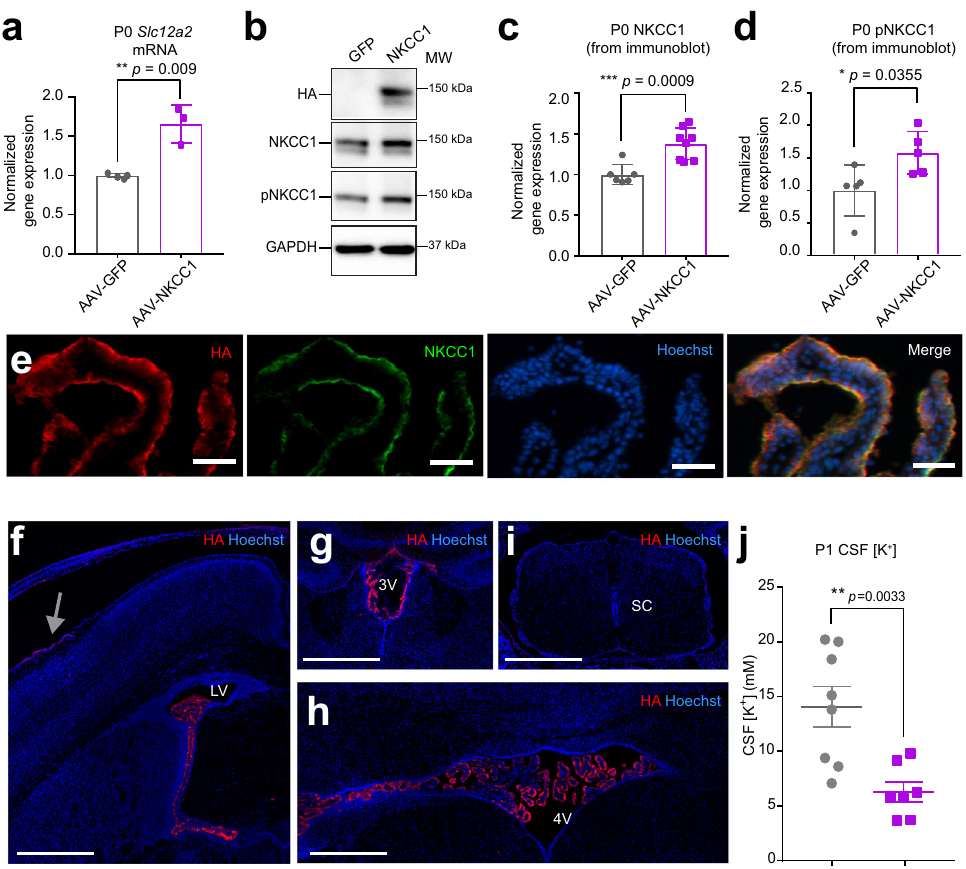
Fig. 4 ChP NKCC1 actively mediates CSF K + clearance during the fi rst postnatal week. a RT-qPCR of NKCC1 mRNA levels in P0 mice. Gray: AAV-GFP; purple: AAV-NKCC1 (same color scheme is used for the rest of this fi gure). ** p = 0.009, N = 3; Welch ’ s two-tailed unpaired t -test. b Immunoblots from AAV-NKCC1 vs. AAV-GFP P0 mice ChP lysates, representative of three independent experiments, each contained multiple biological replicates (the exact numbers and raw blots are included in the Source Data with quanti fi cation presented in panels c and d ). c , d Quanti fi cation of all immunoblots of NKCC1 c *** p = 0.0009, N = 7; Welch ’ s two-tailed unpaired t -test; and pNKCC1 d * p = 0.0355, N = 5; Welch ’ s two-tailed unpaired t -test. All samples for direct quantitative comparison were on the same blot (see Source Data). e Immuno fl uorescence images showing colocalization of 3xHA tag and NKCC1 in P0 ChP. Scale bar = 50 µ m, representative of three independent experiments, each with two biological replicates. f – i Immuno fl uorescence images of HA in AAV2/5-NKCC1 transduced brain at P1: LVChP ( f ), 3 rd ventricle ChP (3VChP) ( g ), 4VChP ( h ), and the spinal cord ( i sc = spinal cord). Trace expression of HA in the meninges near the injection site (gray arrow). Scale bar = 500 µ m. f – i are representative of two independent experiments, each with three biological replicates. j ICP-OES measurements of CSF [K + ] from AAV-NKCC1 vs. AAV-GFP P1 mice ( N = 8 in AAV-GFP cohort; N = 7 in AAV-NKCC1 cohort). ** p = 0.0033; Welch ’ s two-tailed unpaired t -test. All quantitative data are presented as mean ± SD. Source data are provided as a Source Data fi